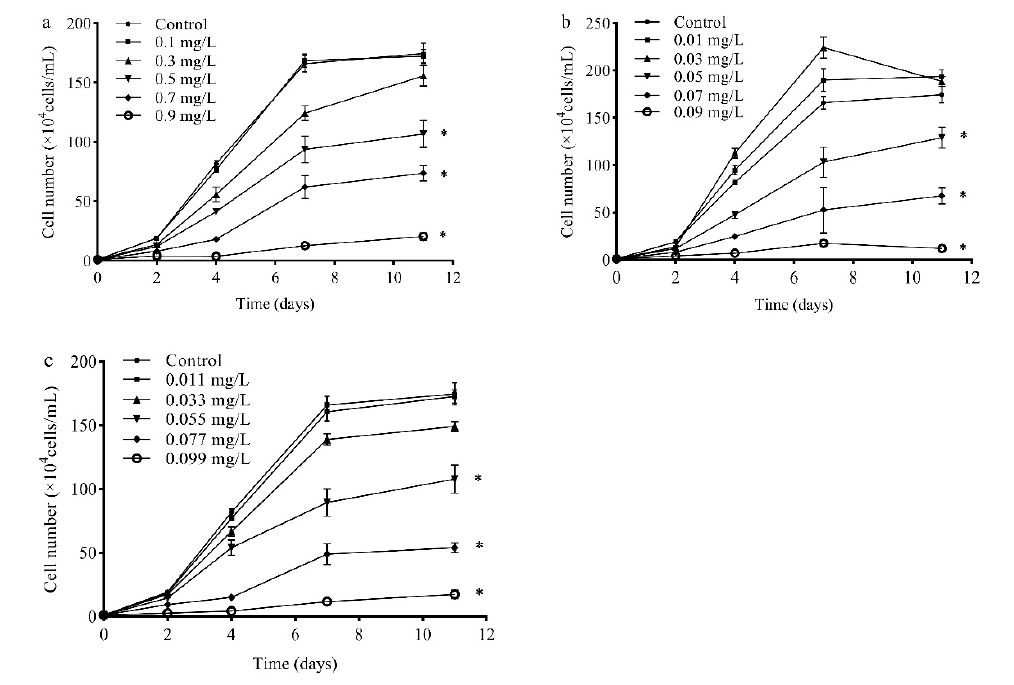
Figure 1. Effects of ( a ) SMX, ( b ) ERY, and ( c ) their mixture on the growth of R. subcapitata in different concentrations. Data are presented as mean values ± standard deviation (n = 3). The asterisk (*) indicates a significant difference ( p < 0.05) between control and treatments. Table 1. Effective concentration (EC 50 ) and risk quotients of SMX, SMZ, and their mixture (SMX: ERY = 10:1) for R.